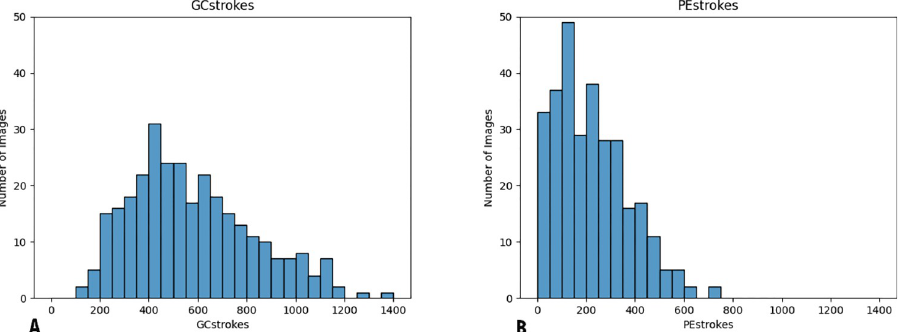
Fig 8. Histograms of GrabCut (A) and PreciseEdge (B) stroke count distributions, bin width is 50 (strokes). The distribution of stroke count for PreciseEdge shows more consistency of images needing fewer strokes (38% fewer) compared to GrabCut processed